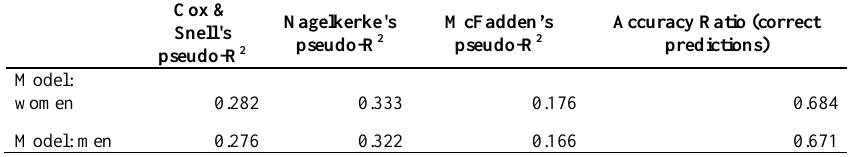
Table 4. Measures of logistic regression model’s